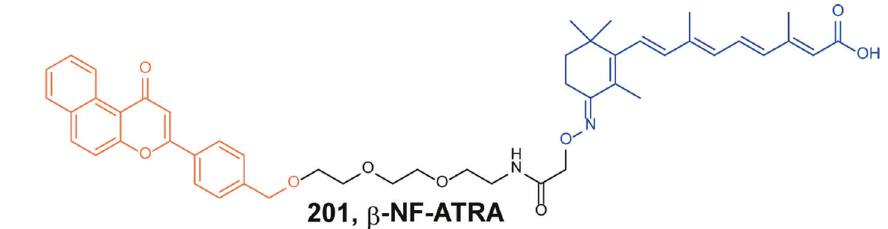
Fig. 56 The representative PROTAC targeting CRABP